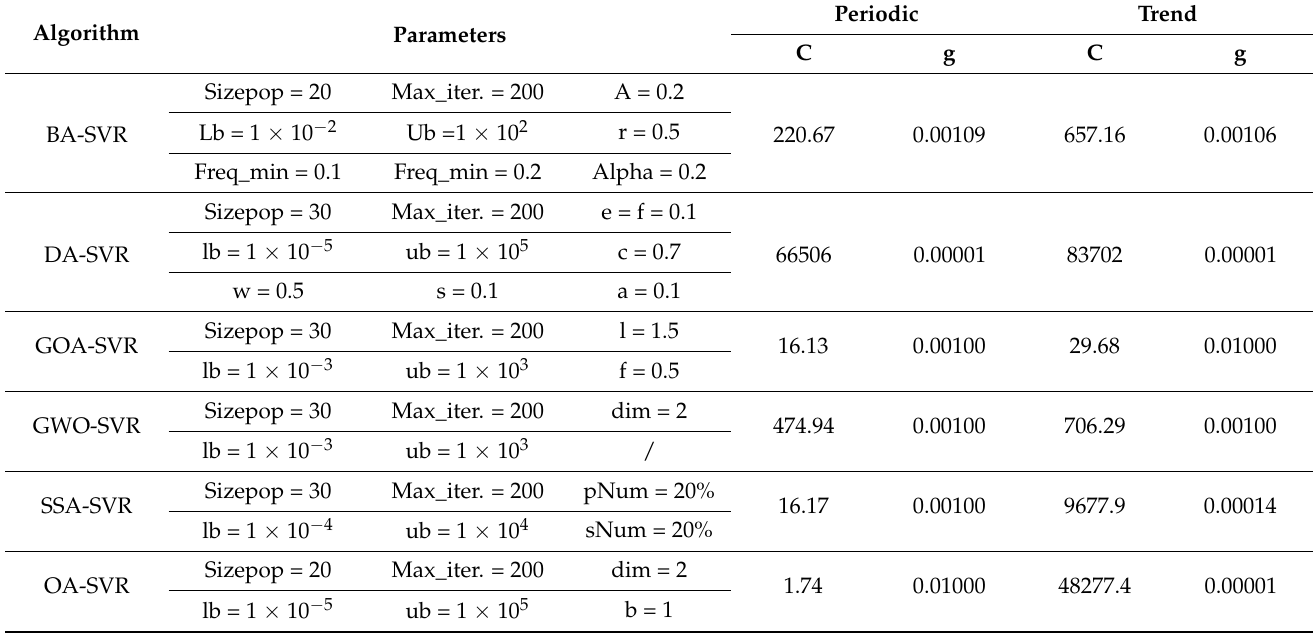
Table 4. Parameter and results of each optimization